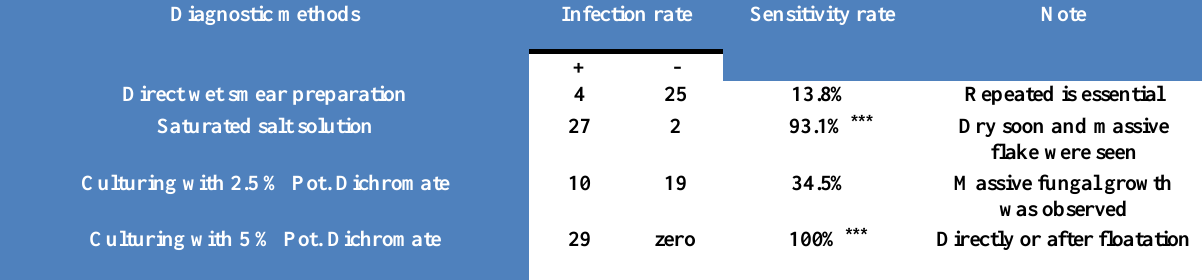
Table, 3: Sensitivity rate of various diagnostic methods that are used for the diagnosis of Eimeria spp infection in local meriz ( Capra ibex )